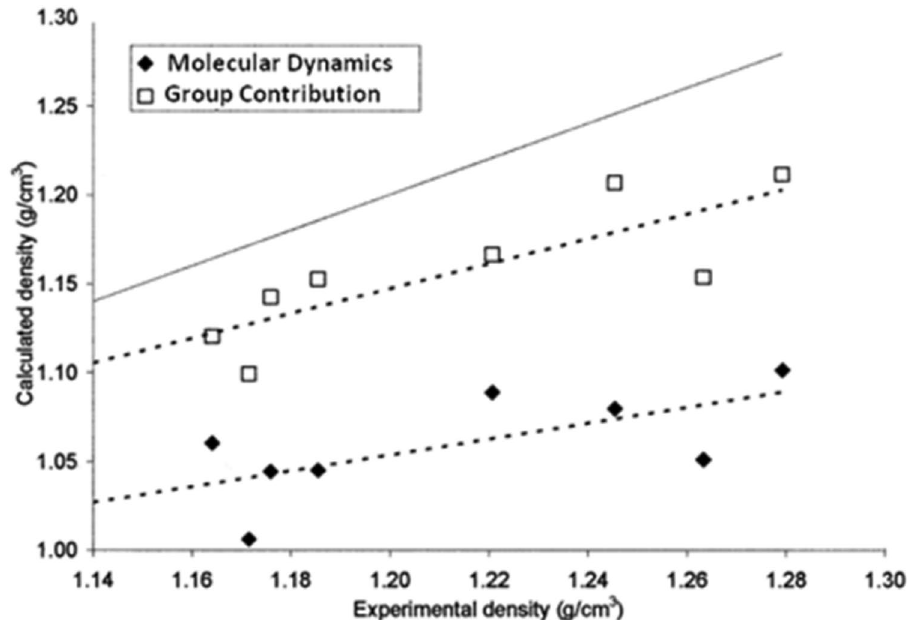
Fig. 8 A comparison of cal- culated densities using group contribution and molecular